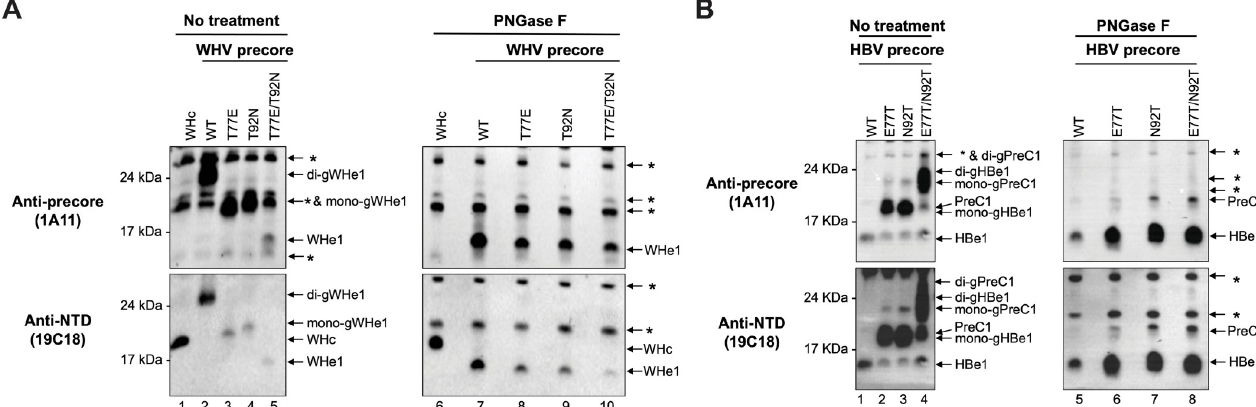
Fig 2. Precore N-glycosylation enhanced the secretion of precore gene products. Immunoblot analysis of (A) WHV and (B) HBV precore gene products in the culture supernatant of Huh7 cells transfected with WHV or HBV precore constructs. The supernatants were concentrated by ultrafiltration and treated with PNGase F or not and resolved by regular SDS-PAGE, followed by sequential immunoblotting with mAb 1A11 and 19C18 on the same membrane. WHV core-transfected cell culture supernatant served as the control for the background bands. WHe1, WHeAg that has the putative cleavage site on the 159 th residue at CTD ( Fig 1A ) as identified previously [28]; mono-gWHe1, mono-glycosylated WHe1; di-gWHe1, doubly-glycosylated WHe1; WHc, WHV core protein; HBe1, HBeAg that has the putative cleavage site on the 154 th residue at CTD ( Fig 1A ); mono-gHBe1, mono-glycosylated HBe1; di-gHBe1, doubly-glycosylated HBe1; PreC1, PreC antigen as previously characterized ( Fig 1A ); mono-gPreC1, mono-glycosylated PreC1; di-gPreC1, doubly-glycosylated PreC1. � , cross- reactive background bands.